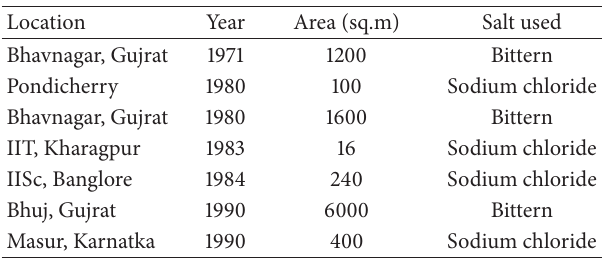
Table 1: Solar ponds in India